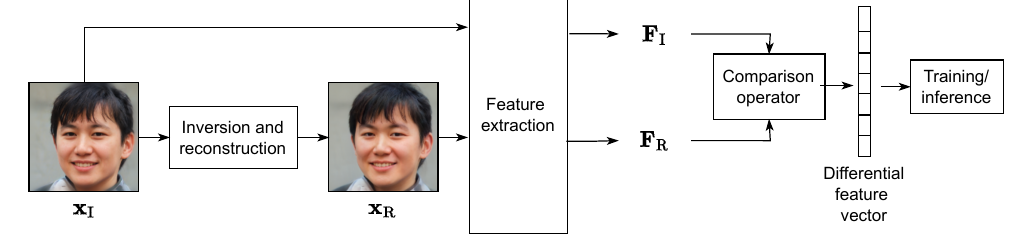
Figure 4. Pipeline of the comparison and training/classification